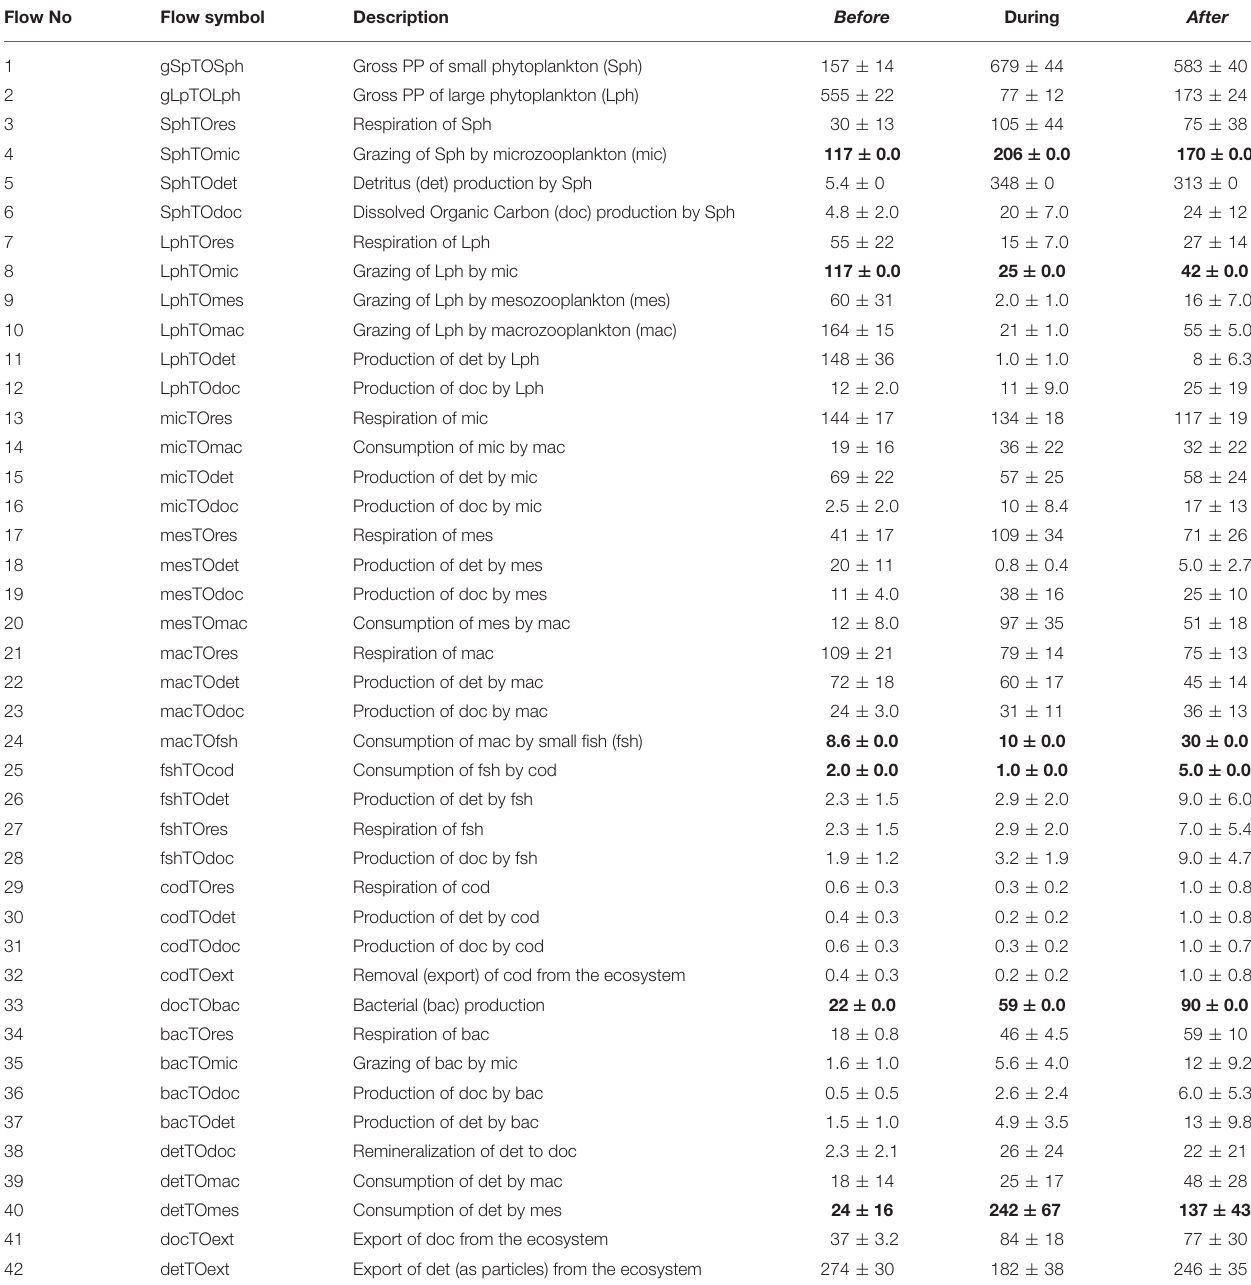
TABLE 1 | Carbon flows in food webs constructed for before , during and after anomalously warm waters in the eastern Fram Strait. Flow No Flow